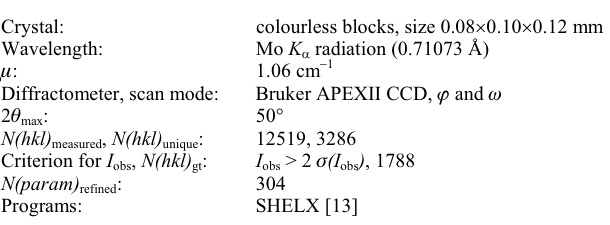
Table 1. Data collection and handling.